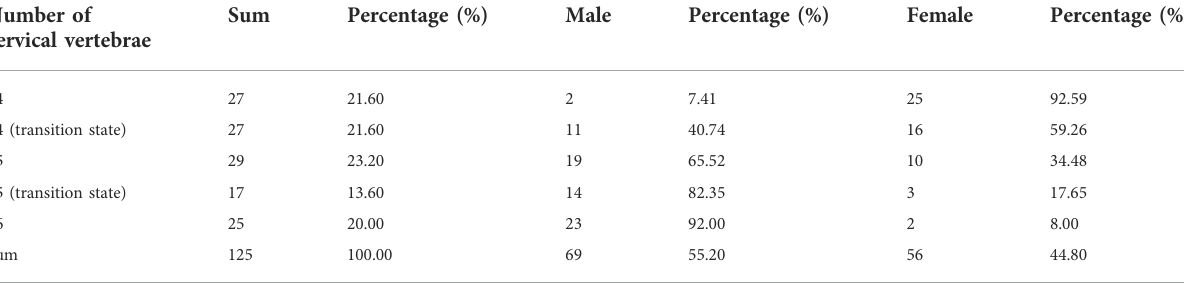
TABLE 3 The distribution of ducks with different numbers of cervical vertebrae in the Pekin duck population used for genome-wide CNV analysis. Number of cervical